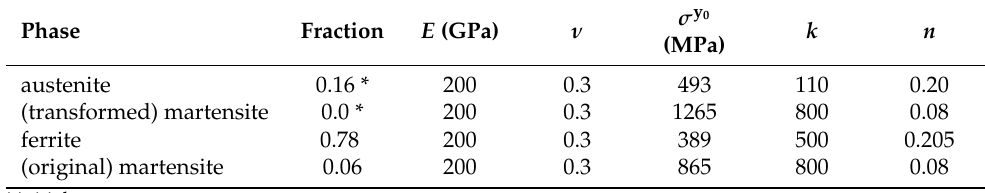
Table 3. Mechanical properties of each phase used in the simulation of TRIP-aided DP steel.